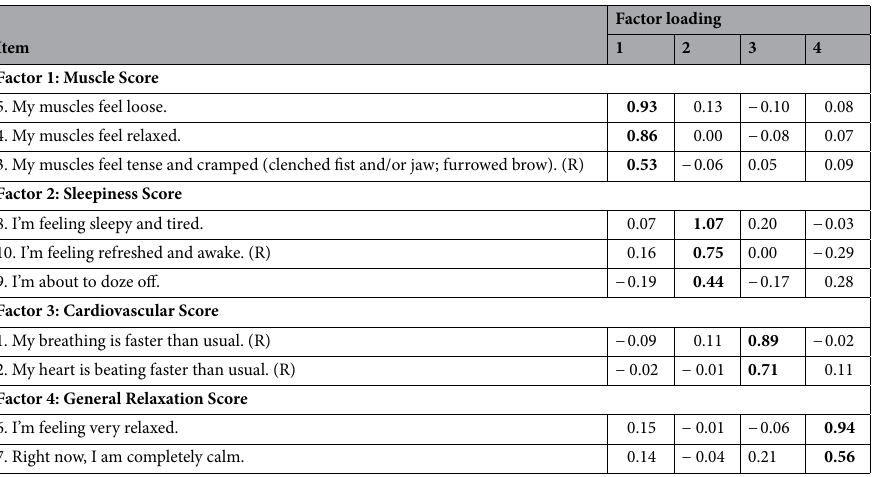
Table 2. Results from the factor analysis of the RSQ. The extraction method was principal axis factoring with an oblique rotation (promax with Kaiser normalization). Factor loadings above 0.40 are in bold. Reverse- scored items are denoted with (R).